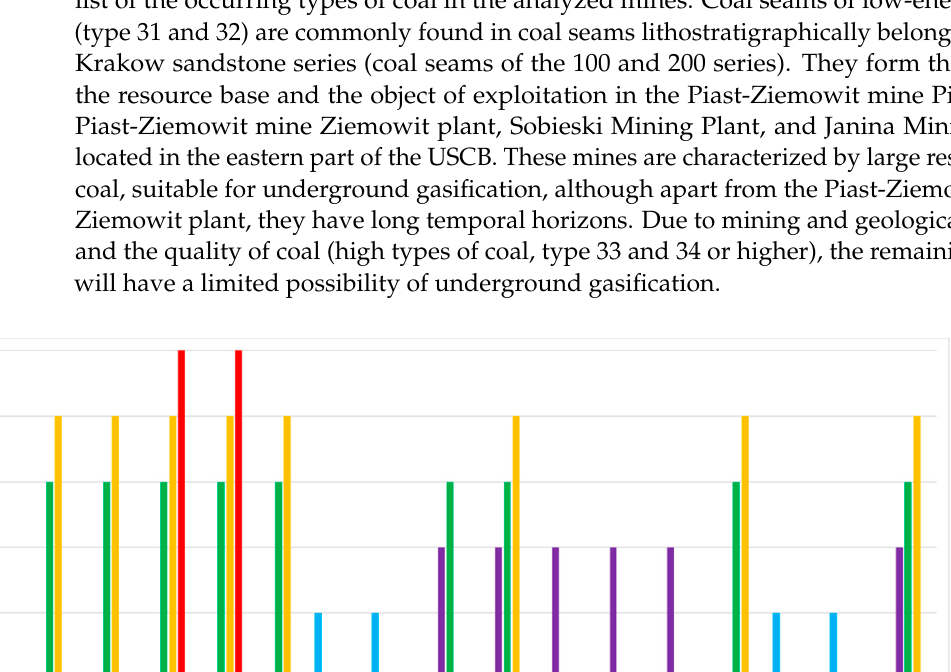
( b ) Figure 7. Maps of structural analysis: ( a ) direct influences/dependences MDI for UCG criterion; ( b ) indirect influences/dependences MII for UCG criterion.